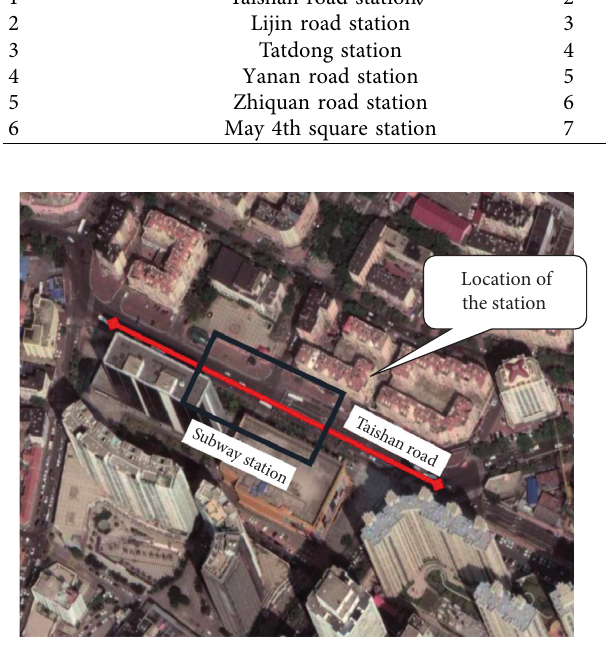
Figure 2: Geographical location of Taishan road